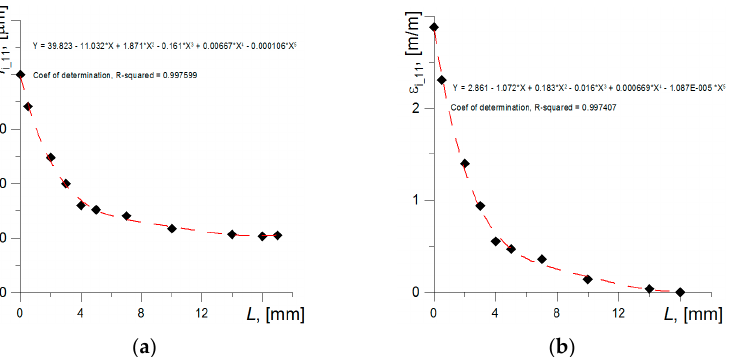
Figure 5. Graphs of changes in ferrite grain length ( a ) and strain level ( b ) in a uniaxially tensile specimen made of S355 steel. The strain level also can be determined with the assumption that the strain is the ratio of the increase in ΔΔ L i to the length of the measuring section Δ L i0 , in the case when the length of the segment Δ L i0 tends to an infinitely small value d :